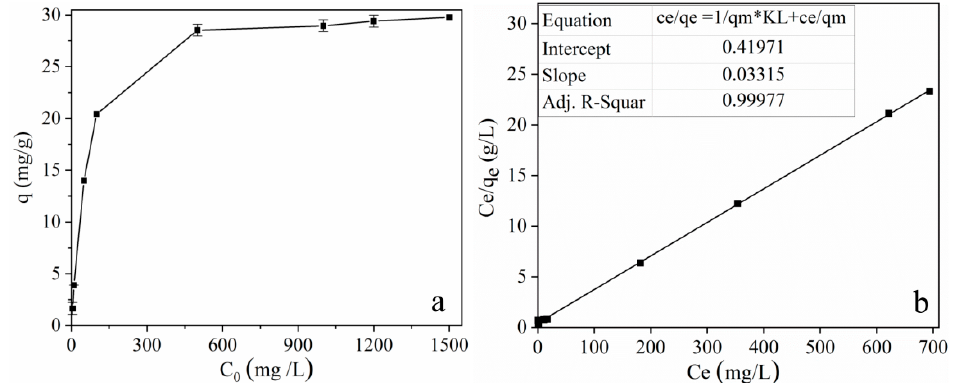
Figure 7. Sorption isotherm of tetracycline by MOF 1 ( a ) and adsorption isotherms fitted by the Langmuir models ( b ). ( V = 10 mL, m (adsorbent) = 20 mg, T = 25 ◦ C, t = 24 Table 2. Adsorption isotherm parameters for adsorption of tetracycline.